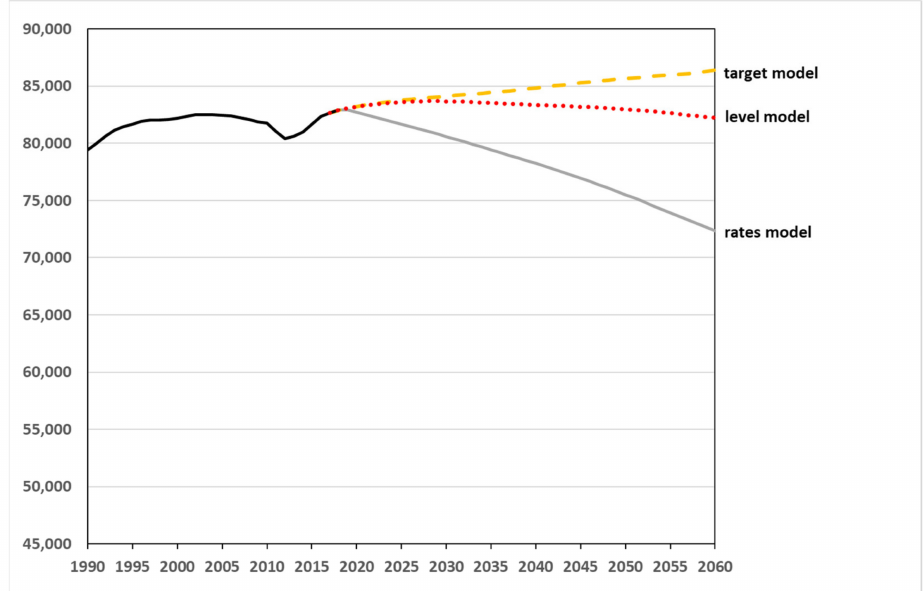
Figure 7. Development of Germany’s population size (Germans and non-Germans) until 2060 (in k)—simulation results from 2019 onwards. (Sources: [55]; own computation and design.)